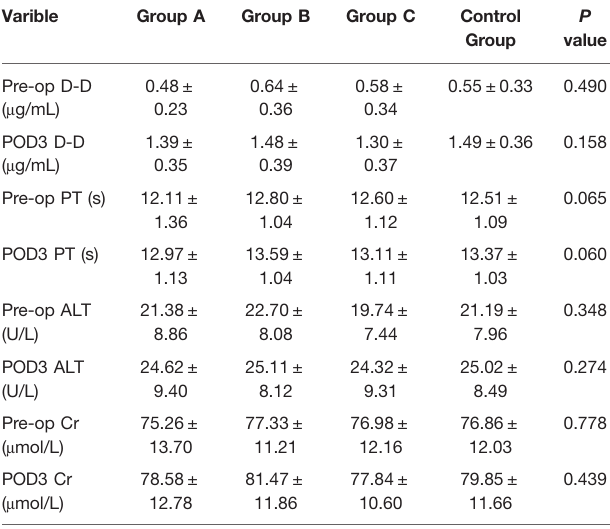
TABLE 3 | Preoperative and postoperative blood biochemical indexes among the 4 groups.